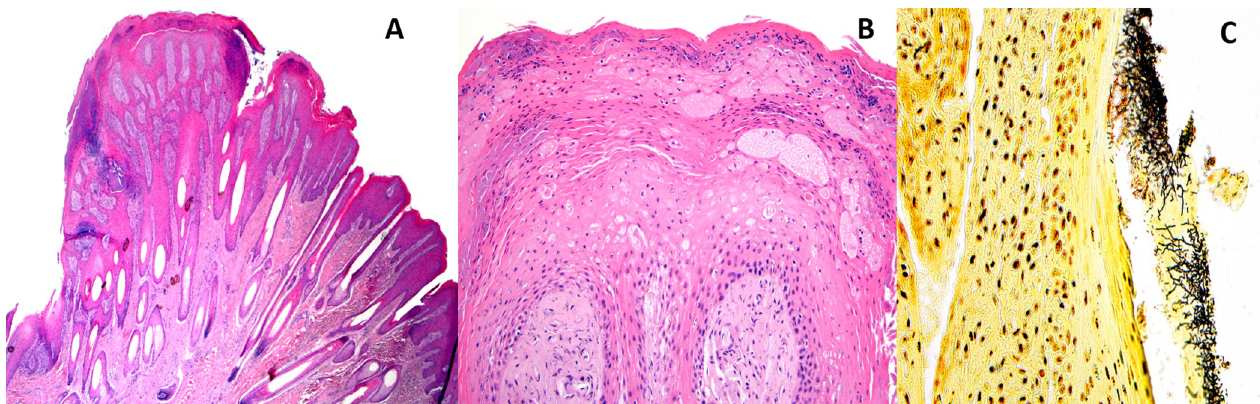
Fig 5. Characteristic histologic changes in affected haired skin from huemul limb (Case #10, Table 1). A) The epidermis is markedly hyperplastic and thrown up into multiple folds. Short rete pegs extend into the subjacent dermis (HE). B) Additional epidermal changes include moderate compact orthokeratotic and parakeratotic hyperkeratosis and mild to severe intracellular edema. Multifocal superficial areas containing smudgy, basophilic material contain degenerate cellular debris admixed with mixed bacteria (HE). C) Myriad long bacteria are stained dark brown and are focally present in this section of an acellular crust overlying the stratum corneum. Short bacilli and cocci that are more lightly stained are present along the base of the crust (Warthin Starry).